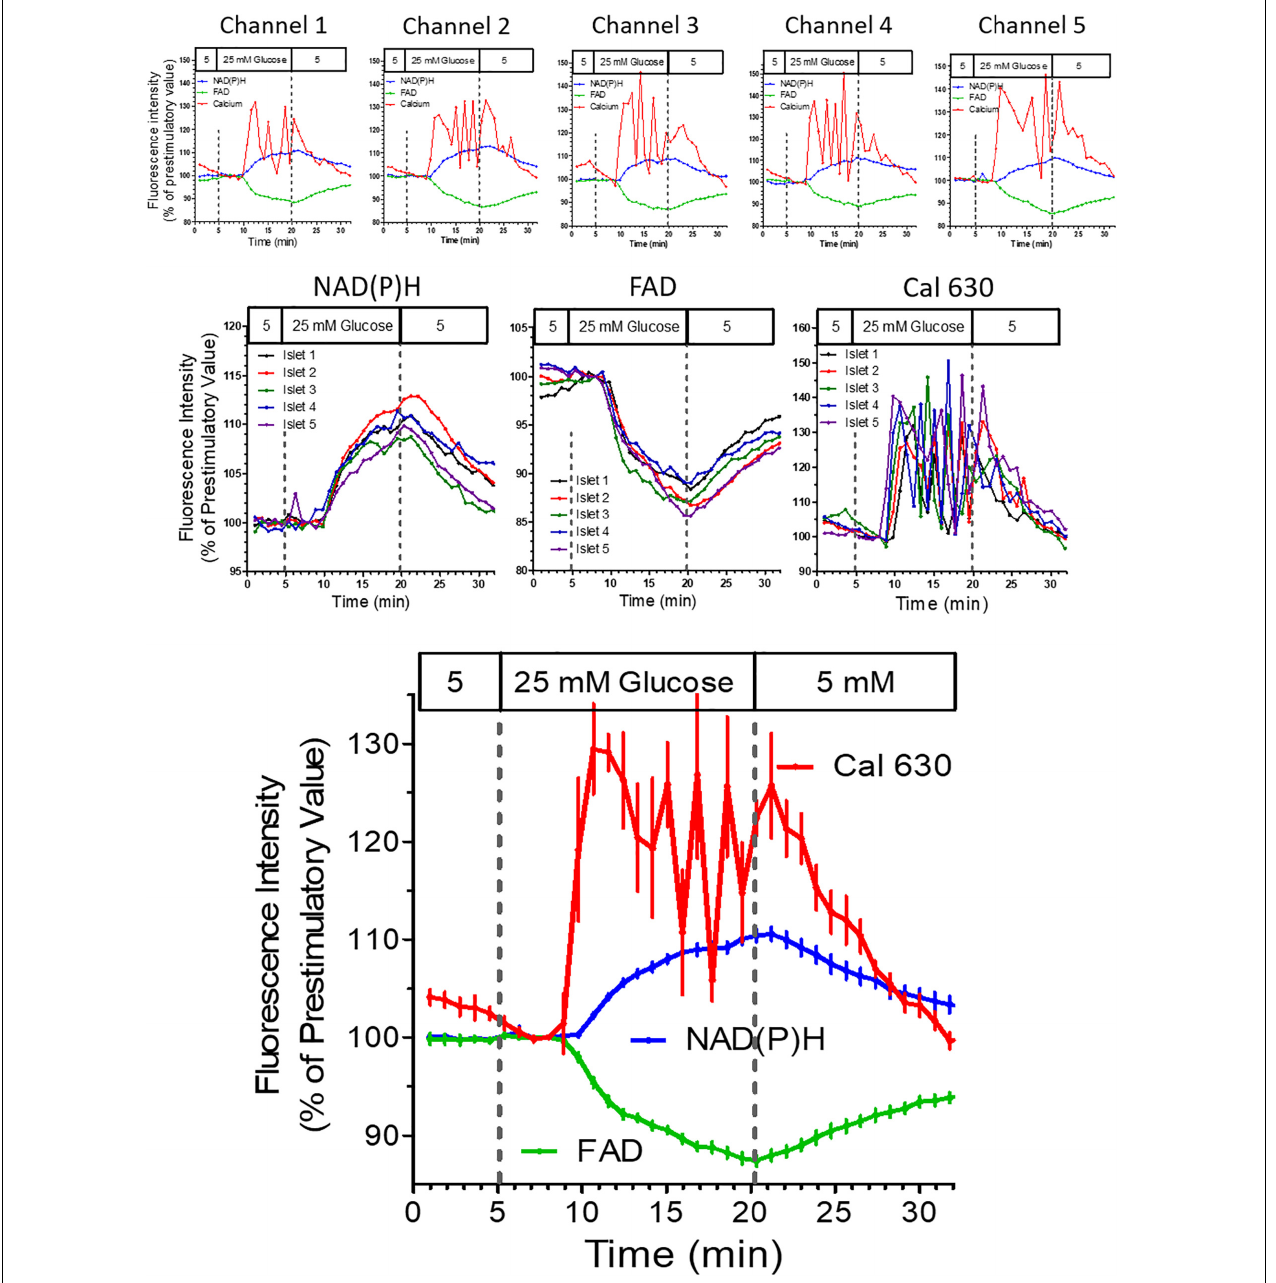
FIGURE 8 | Multiparametric measurements in parallel perifused islets stimulated with glucose. Five islets were loaded with Cal 630 AM, placed in the wells, one each per well, and perifused with KR medium. From 5 to 20 min the glucose concentration of the perifusion medium was raised to 25 mM. The intensity was normalized to the values at 8 min (the time point when the medium reached the wells). The single fluorescence traces per islet are shown in the upper row, the single fluorescence traces per parameter are shown in the middle row. The lower graph shows the mean values ± SEM of the traces shown above. The onset of the oscillatory pattern of the cytosolic Ca 2 + concentration (Cal 630 fluorescence) after 5 min contrasts with the continuous increase of the NAD(P)H-fluorescence and the continuous decrease of the FAD-fluorescence.